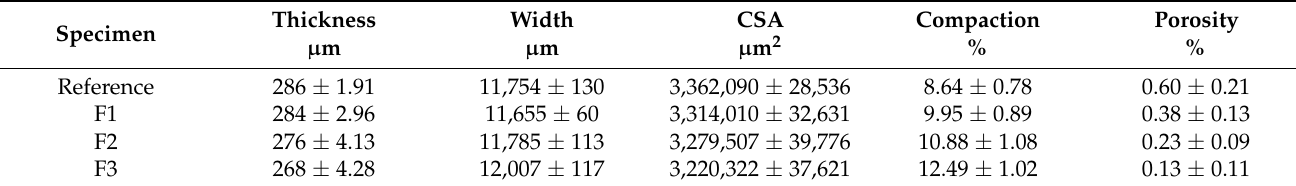
Table 2. Experimental results for compaction and